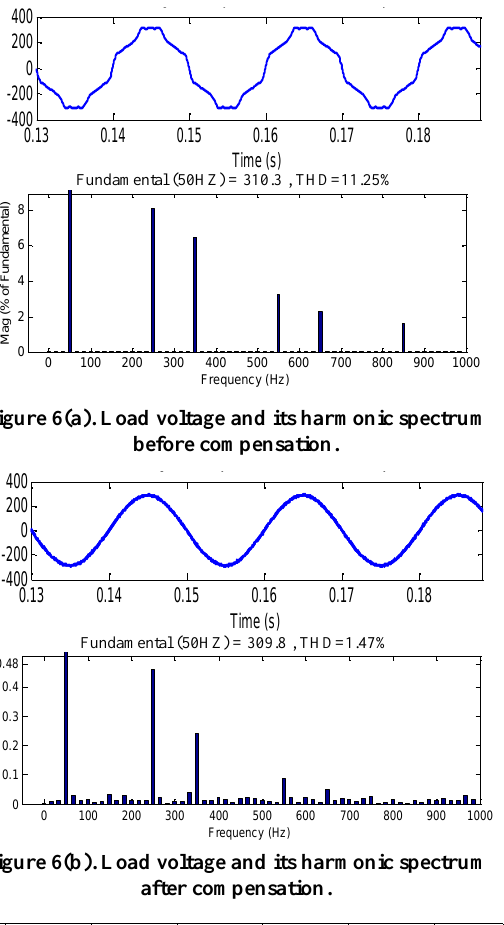
Figure 6(b). Load voltage and its harmonic spectrum after compensation.